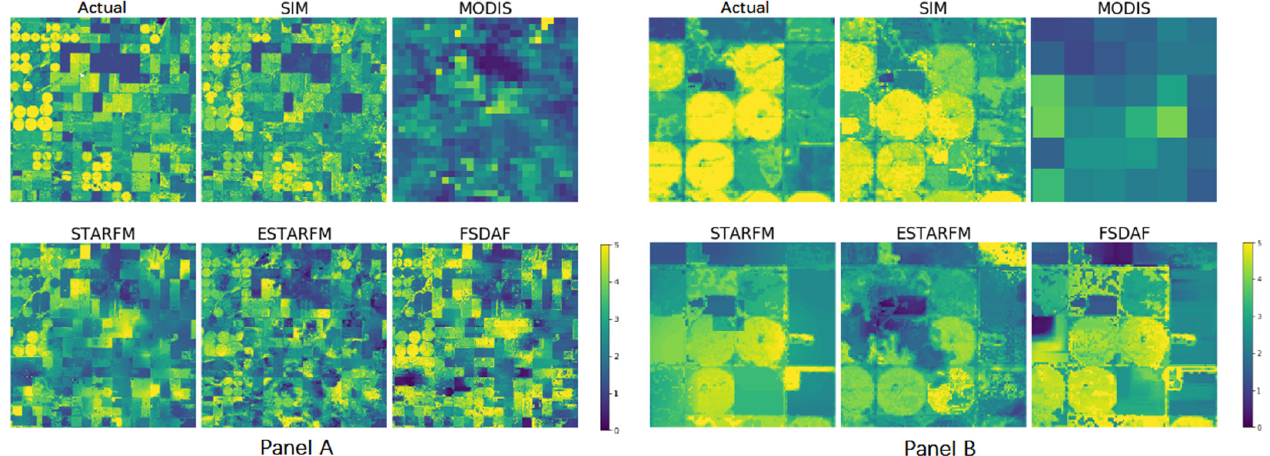
Figure 8. Actual and predicted LAI images using different methods at the CSD area from DOY 191. A zoomed-in area of all images is shown in Panel B. Table 5. Accuracies of different methods for NDVI and LAI prediction at the CSD area from DOY 191.